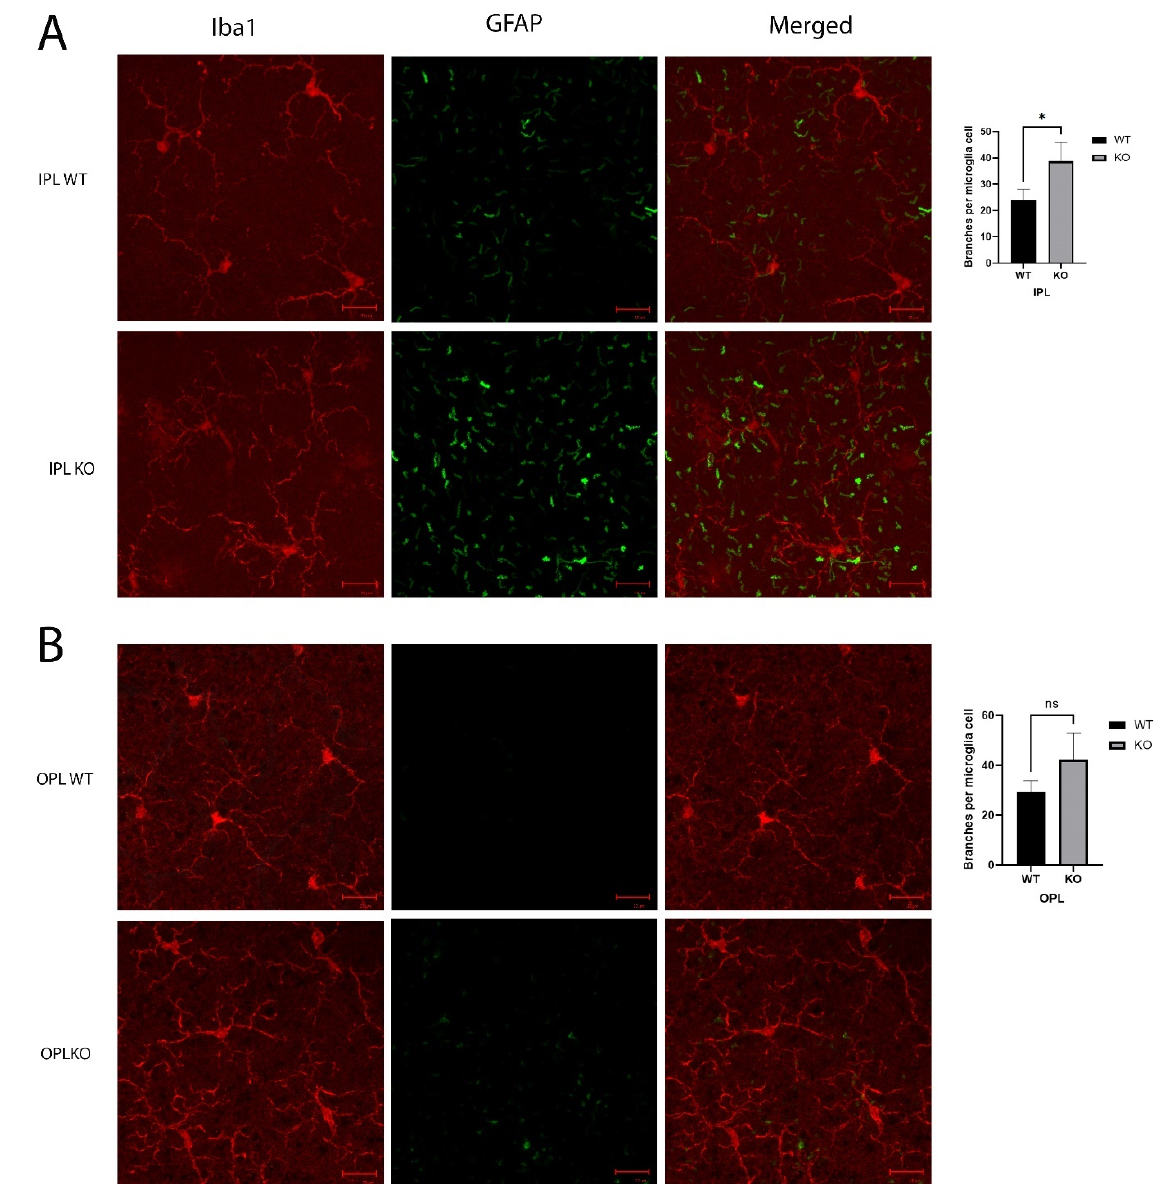
Figure 6. Morphology of microglia in the ( A ). IPL and ( B ). OPL. Microglia are shown by Iba1 in red and extended astrocyte processes labeled with GFAP in green. Quantification of the number of branches per microglial cell is exhibited in bar graphs. * p < 0.05 unpaired two-tailed t -test. 20 Cells were counted per mouse for 10 mice in each group. Scale bar: 20 µm. ns: not significant.